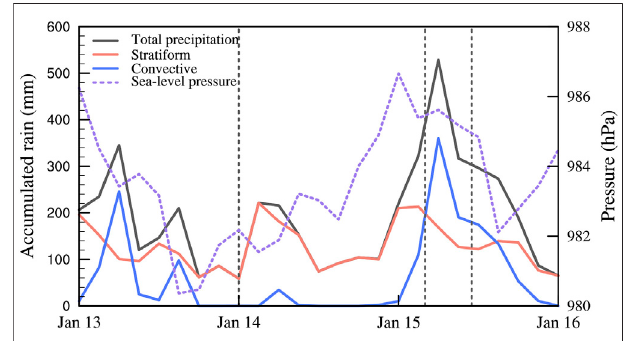
FIGURE 5 | Time series of minimum sea-level pressure (purple dashed, hPa), total (black curve), convective (blue), and stratiform (red) precipitation within a radius of 150 km of Cody every 3 h from 0000 UTC January 13 to 0000 UTC January 16 The three dashed lines are the same as in Figure 4